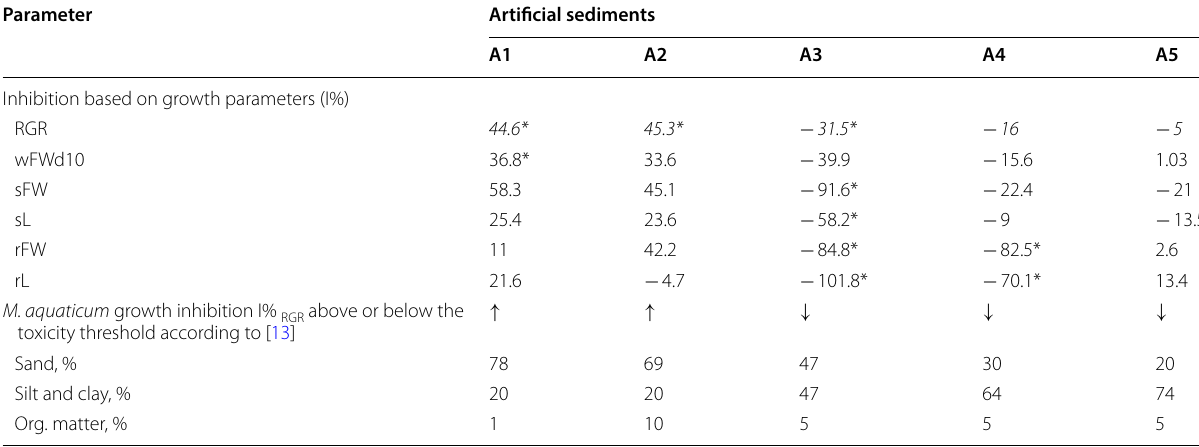
of artificial sediments